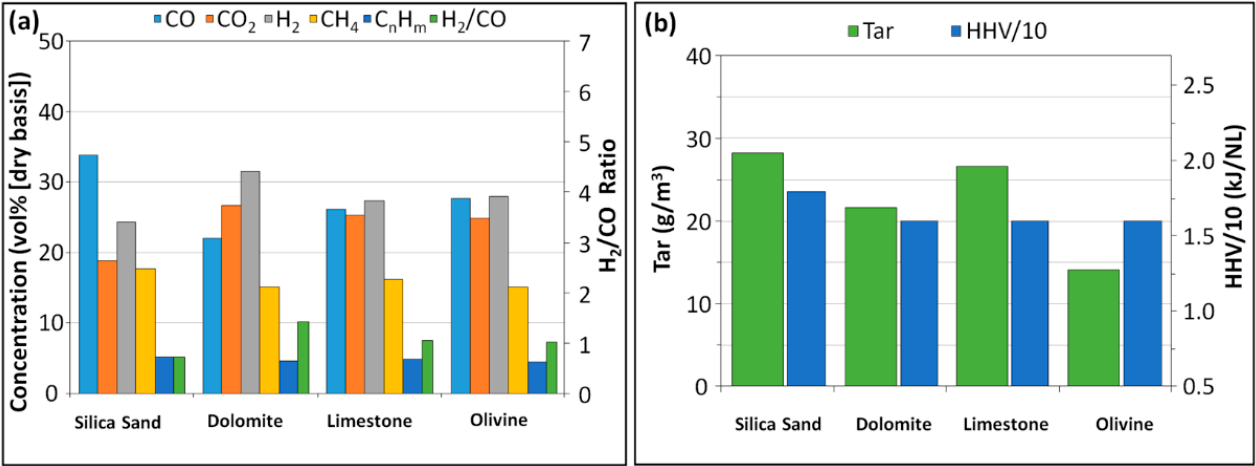
Figure 4. Effect of the catalyst type on ( a ) gas composition and H 2 /CO ratio, and ( b ) tar content and high heating value (HHV), as obtained by gasification of WST at 800 °C with oxygen and steam, ER = 0.13, steam/lignin = 0.35 g/g(daf). Silica sand was used as fluidization medium, with or without the addition of each catalyst. NL, volume of syngas in L at standard conditions of temperature and pressure: 293.15 K, 1.0 × 10 5 Pa absolute pressure.